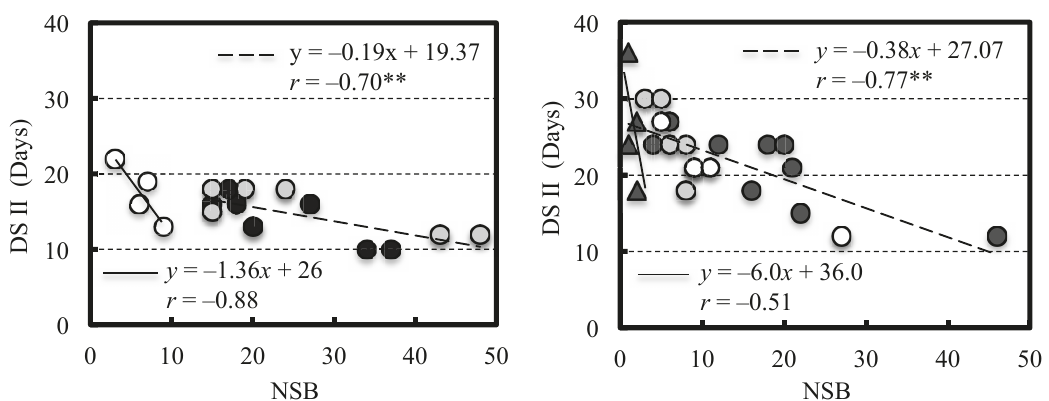
Figure 2. Difference in the effect of NSB on DS II between self-pollination and the other forms of pollination in Bluejay ( left ) and Herbert ( right ) as the seed parent. Each symbol in Bluejay represents the same as in Figure 1. In Herbert, each symbol indicates the following; open-pollination (open-circles); hand-pollination with Herbert (closed triangle), Bluejay (closed circles) and Darrow (shaded circles). ** indicates significant at p =